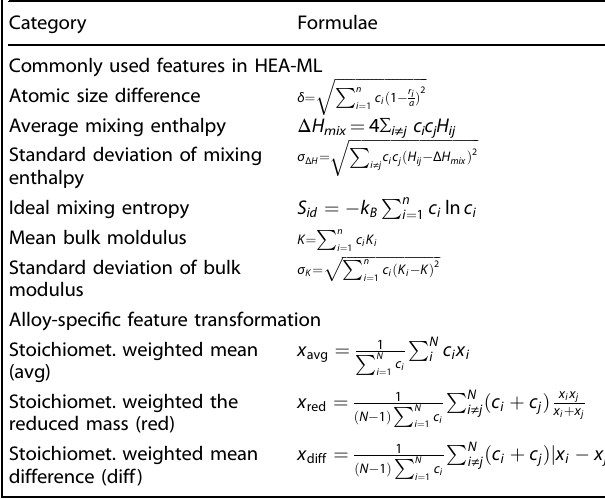
Table 2. Feature generation equations. Table depicting the different formulae to calculate different features. Category Formulae Commonly used features in